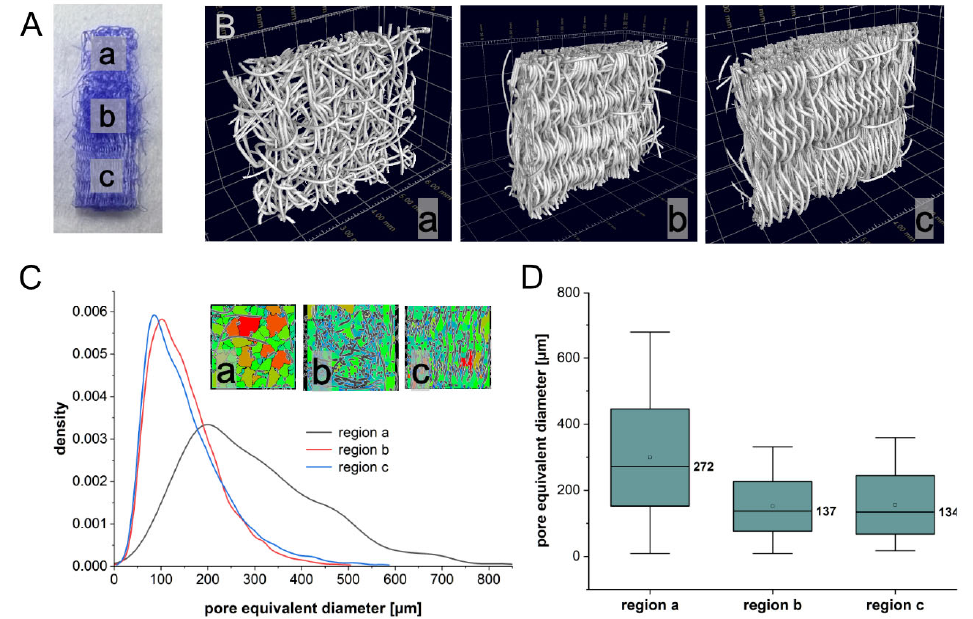
Figure 1. Analysis of scaffolds with micro-computed tomography. ( A ) µ CT measurement regions within the triphasic scaffold. ( B ) 3D visualization of reconstructed CT images for the three regions: ( a ) bony, ( b ) transition, ( c ) ligament. ( C ) Distribution of the pore equivalent diameter representing irregular pore volumes. ( D ) Pore equivalent diameter for the different regions of the triphasic scaffold with median values.